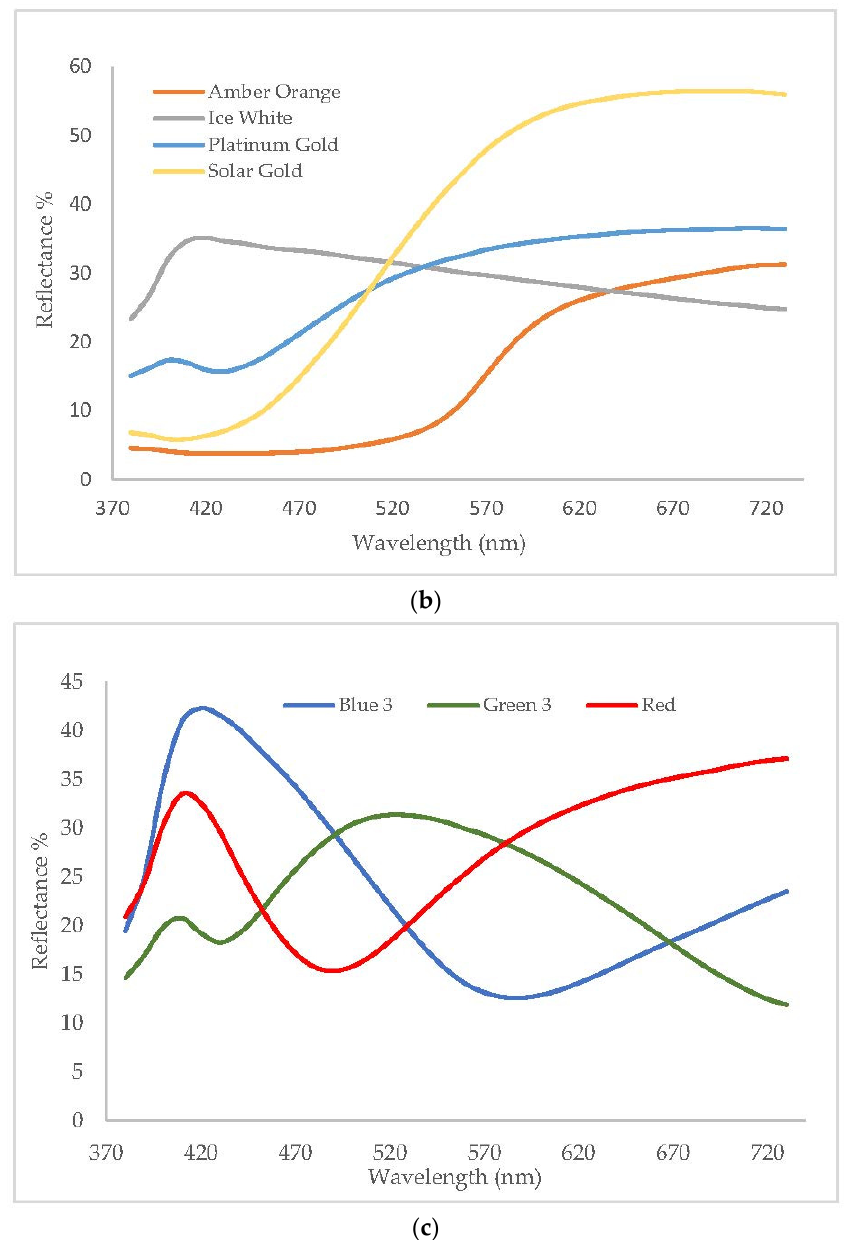
Figure 3. ( a ) Reflectance of Van Son Process Cyan, Magenta and Yellow inks on. ( b ) Reflectance of Spectraval™ Iriodin™ and Prysma™ inks ( c ) Reflectance of Spectraval™ inks. All measurements made with i1Pro colorimeter. Table 5. Color measurements of inks on black Plike paper. The associated uncertainty of L*, a* and b*w is the standard deviation of the